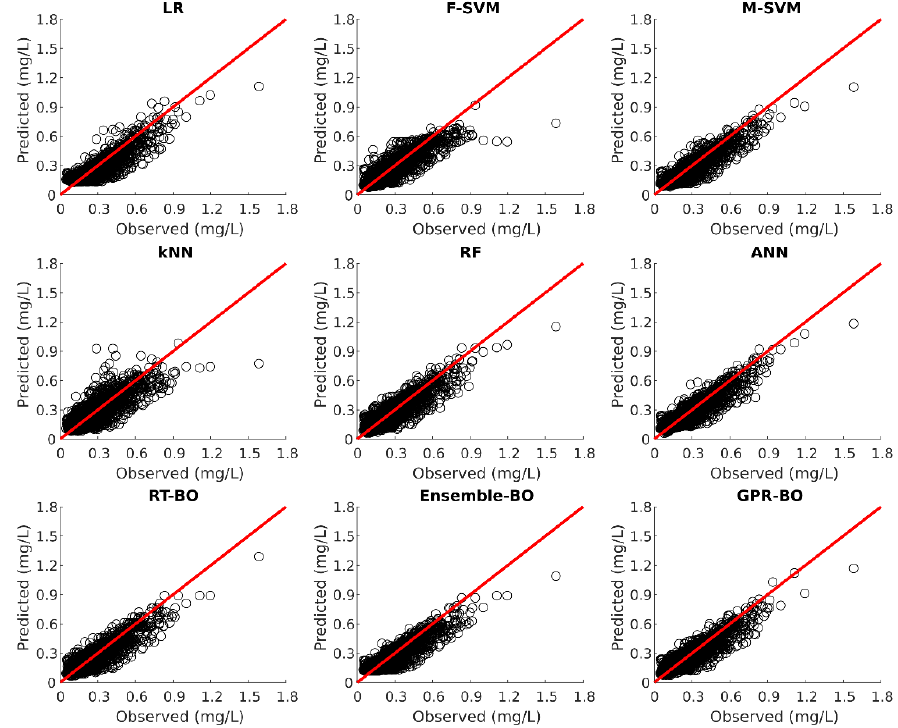
Figure 10. Observed versus predicted daily phosphorus concentration for Maumee using different ML.